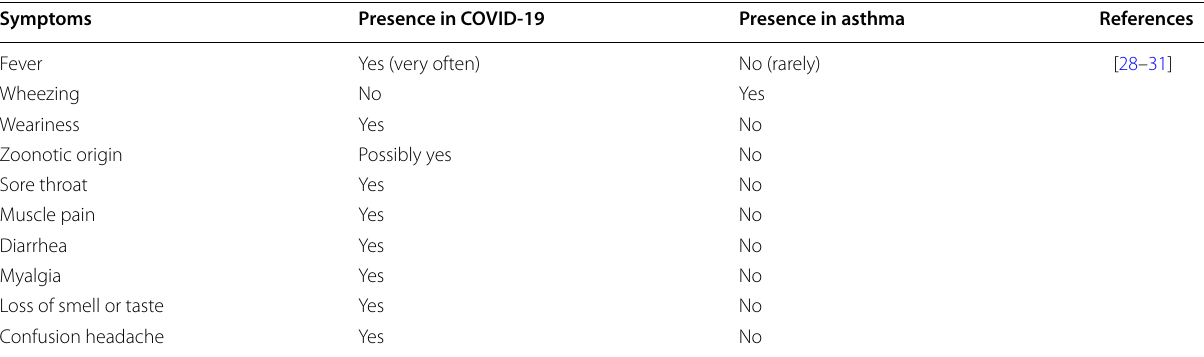
Table 3 Overlapping symptoms between COVID-19 and